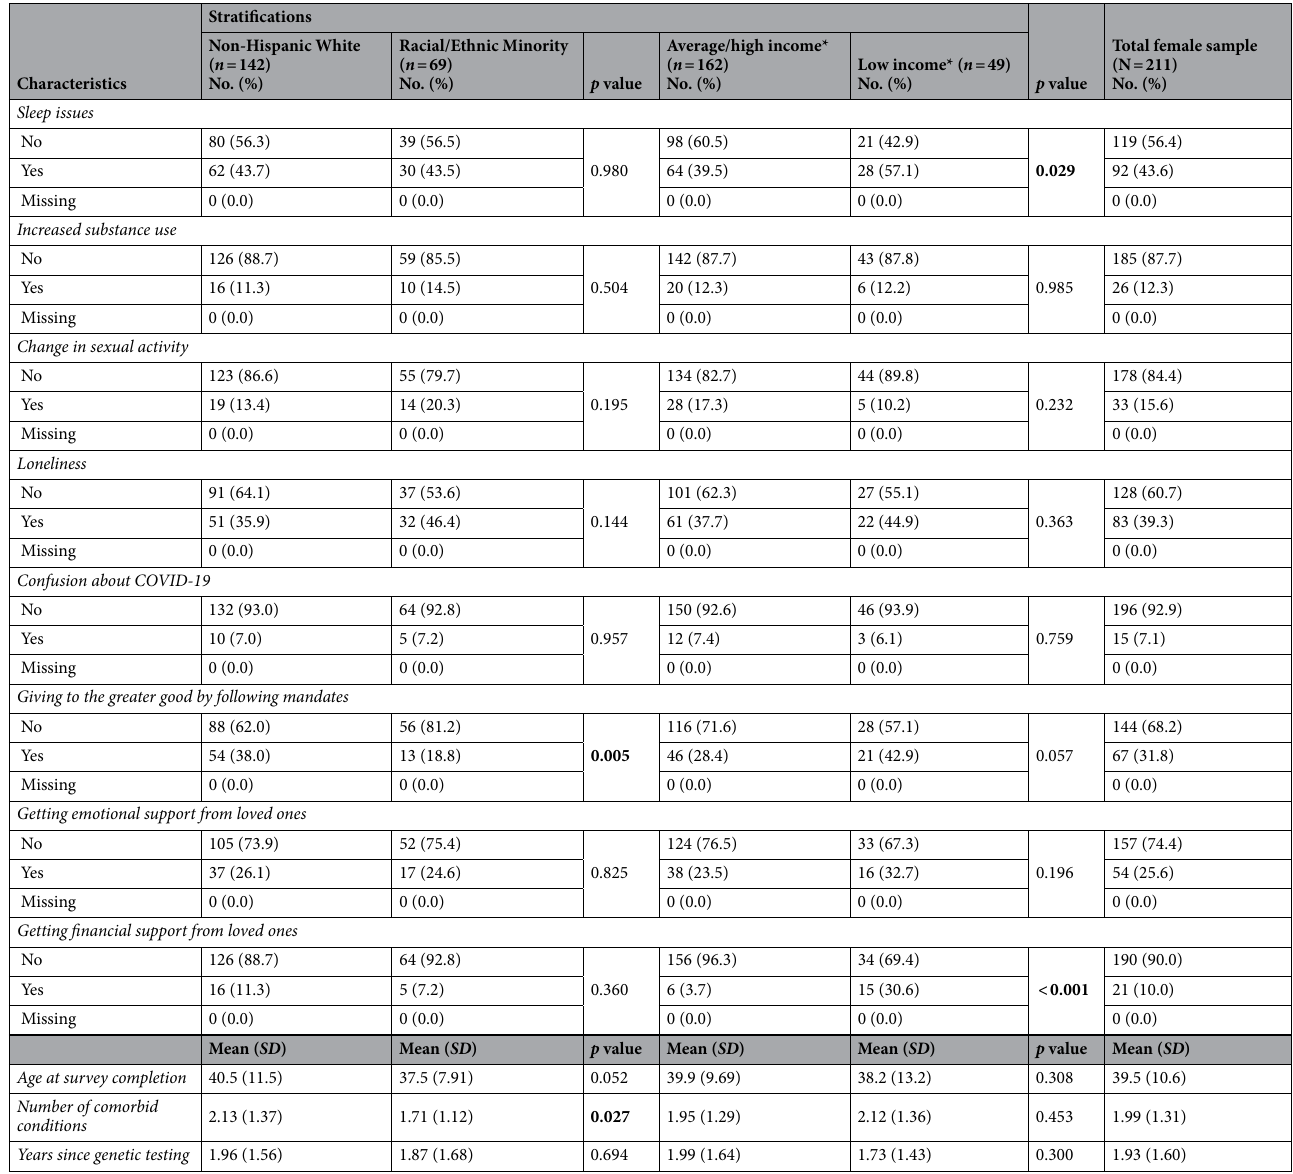
Table 1. Participant demographic characteristics and disadvantaged health population factors, overall and by income status and racial/ethnic minority status. LGBTQ+ = lesbian, gay, bisexual, transgender, queer, or questioning, or other. Disadvantaged health characteristics also include income status and racial/ethnic minority status. Bolded font indicates significant p value (< 0.05). *Income status = annual household income less than $40,000